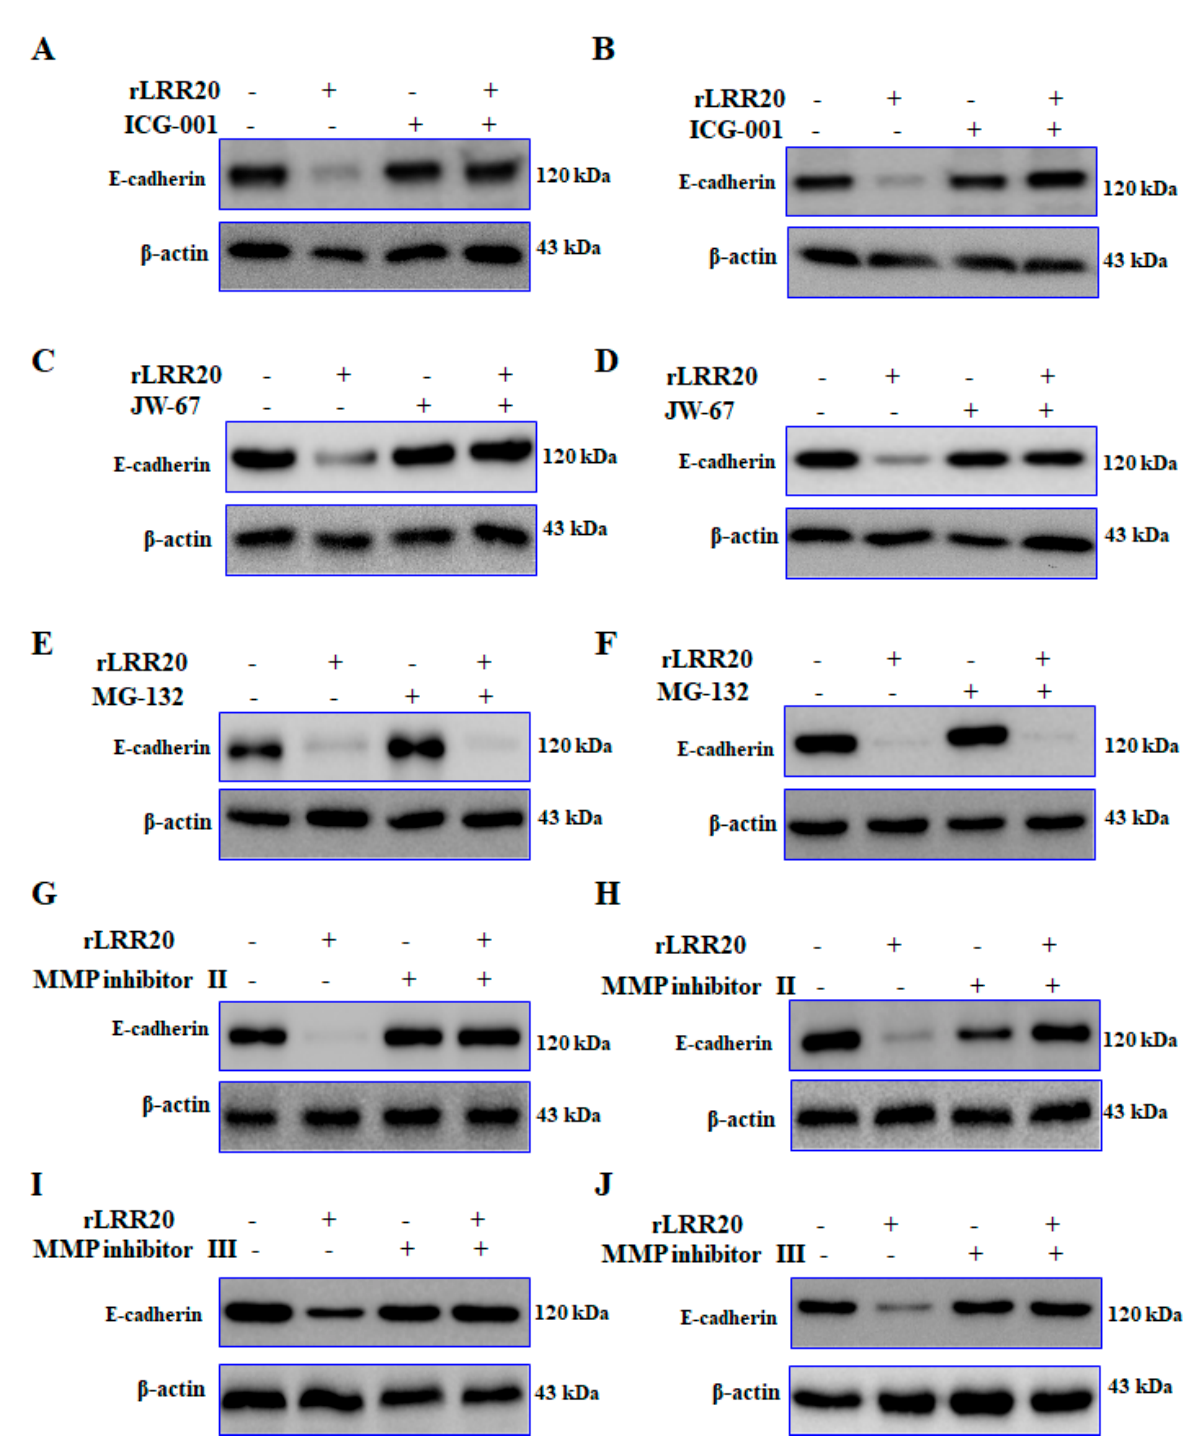
Figure 6. rLRR20 promotes the degradation of E-cadherin. rLRR20-induced degradation of E-cadherin was determined using various inhibitors. Effect of ICG-001, a β -catenin inhibitor, on the rLRR20-induced degradation of E-cadherin in HK2s ( A ) and hRPTECs ( B ). Effect of JW-67, a β -catenin inhibitor, on the rLRR20-induced degradation of E-cadherin in HK2s ( C ) and hRPTECs ( D ). Effect of MG-132, a proteasome inhibitor, on the rLRR20-induced degradation of E-cadherin in HK2s ( E ) and hRPTECs ( F ). Effect of MMP inhibitor II, an MMP7 inhibitor, on the rLRR20-induced degradation of E-cadherin in HK2s ( G ) and hRPTECs ( H ). Effect of MMP inhibitor III, an MMP-7 inhibitor, on the rLRR20-induced degradation of E-cadherin in HK2s ( I ) and hRPTECs ( J ). β -actin was used as the internal control.